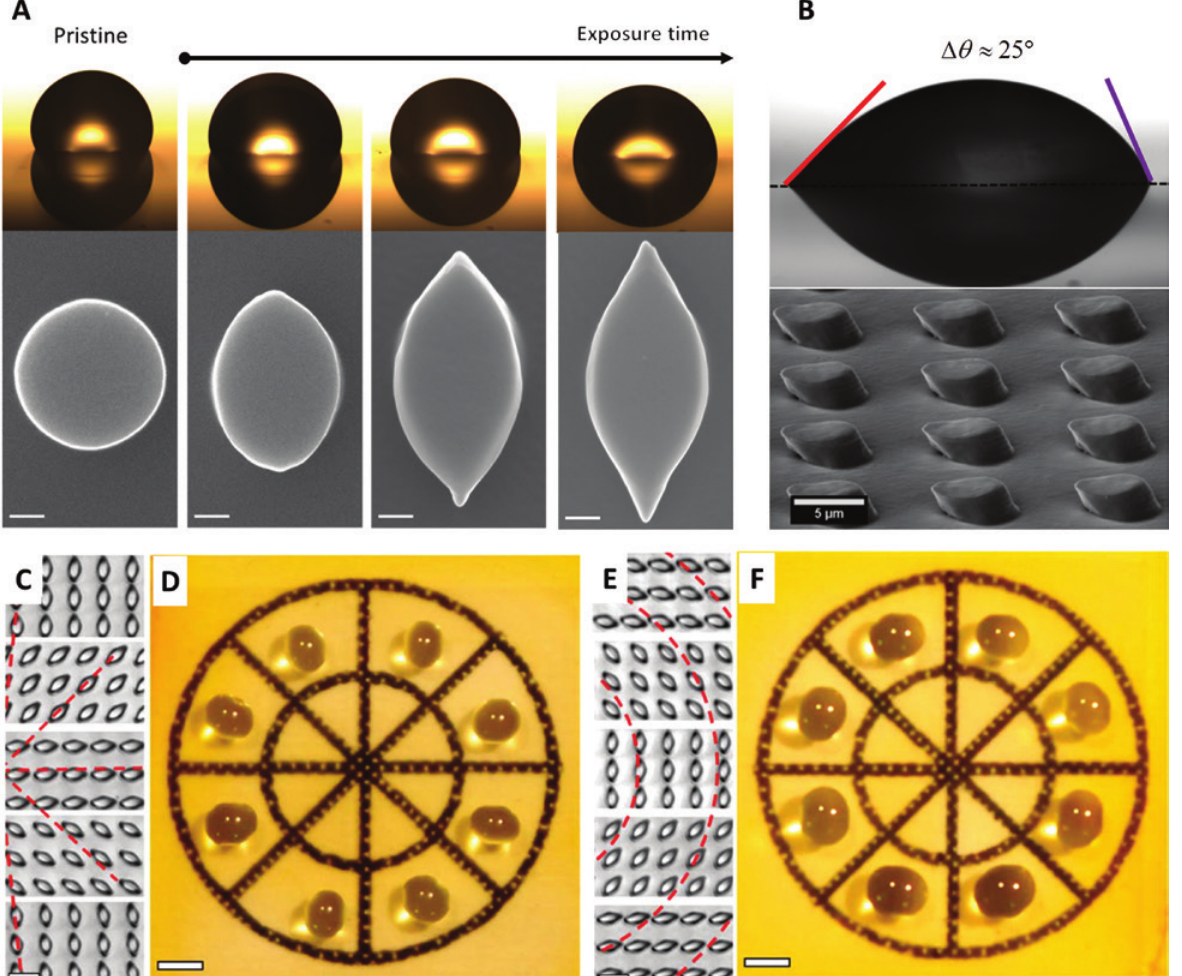
Figure 20: Anisotropic wetting behavior of azopolymer micropillars reconfigured with linear light polarization. (A) Optical images (top) of water droplets highlighting the variation of the contact angle observed along the direction of the long axis of the asymmetric reconfigured azopolymer microstructures shown in the SEM images (scale bar: 1 μ m) at increasing light irradiation time. Unidirectional left-right wetting anisotropy induced onto a liquid droplet deposited onto the array of tilted micropillar resulting from the irradiation of the pristine cylindrical micropillars at the incidence angle of ϕ = 45 ° . (C) and (E) Optical micrographs of different regions of the array of pillars reshaped with the radially and azimuthally polarized beams, respectively (scale bar: 10 μ m). (D) and (F) Photographs of liquid droplets placed in different regions of the radially and azimuthally reconfigured array, respectively (scale bar: 1 mm). Adapted with permis- sion from Ref. [267], copyright 2017, American Chemical